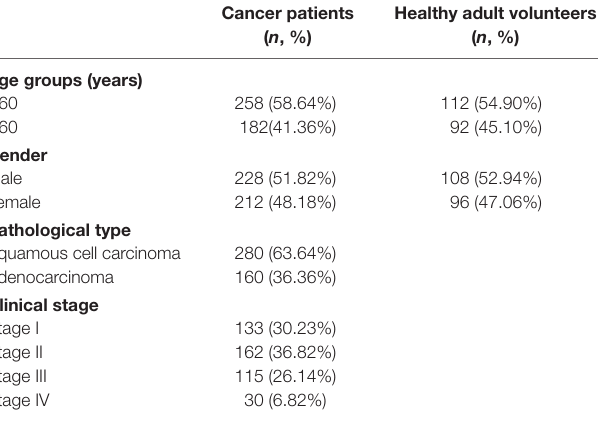
Table 1 | Demographics of study participants with assayed samples ( N =